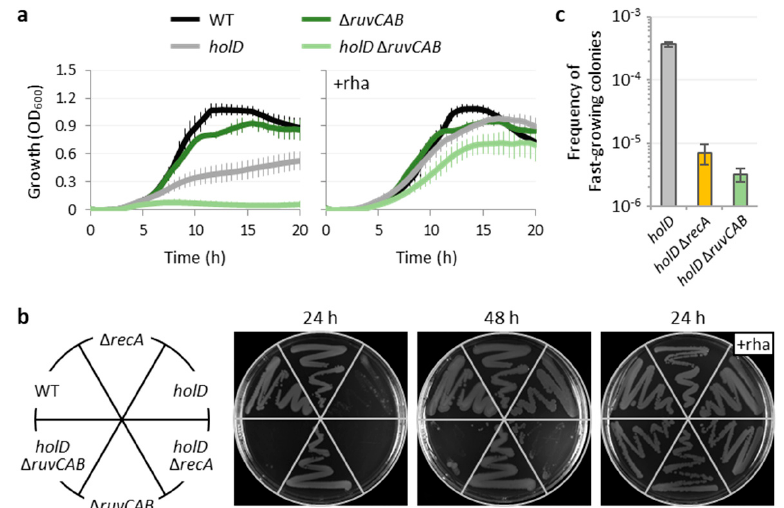
Figure 6. Homologous recombination is responsible for the residual growth of HolD-depleted P. aeruginosa cells. ( a ) Growth curves of the P. aeruginosa wild-type (WT) strain PAO1, the holD condi- tional mutant ( holD ), and the cognate recA and ruvCAB deletion mutants in MH at 37 °C. Data are the mean of three independent assays. ( b ) Growth on MH agar plates of the same strains described in panel ( a ) after 24 and 48 h of incubation at 37 °C. Images are representative of several independent experiments. When indicated, liquid and solid media were supplemented with 0.01% rhamnose (+rha). ( c ) Frequency of fast-growing colonies obtained on MH agar plates without rhamnose for the same strains described in panels ( a , b ). Data are the mean (±SD) of five independent assays.